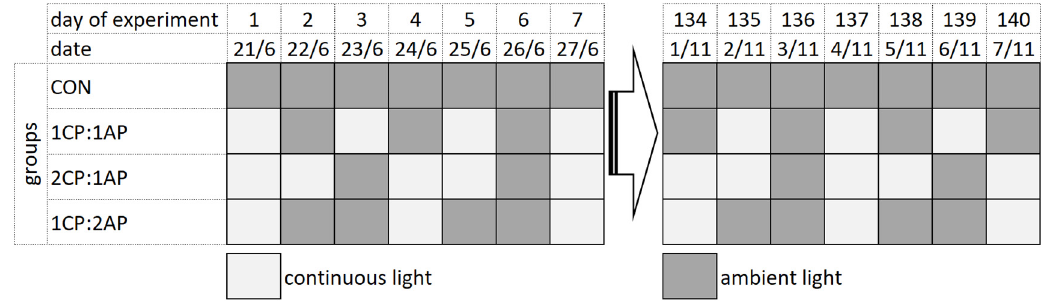
Figure 1. Experimental design for testing non-circadian photoperiod on growth and puberty onset of brook trout Salvelinus fontinalis . 2CP:1AP—group exposed to 24 h of ambient photoperiod alternating with a 48 h of continuous light, 1CP:2AP— group exposed to 48 h of ambient photoperiod alternating with a 24 h of continuous light, 1CP:1AP—group exposed to 24 h of ambient photoperiod alternating with 24 h of continuous light, and CON—group exposed to natural ambient photoperiod as a control.